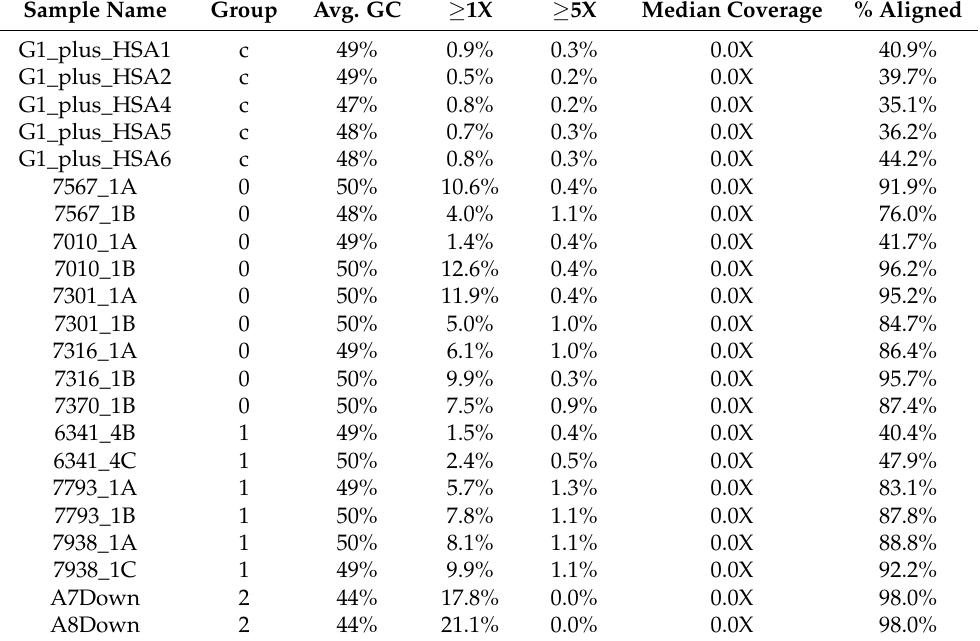
Table 1. Mapping quality metrics of the selected control media samples (c.), culture media droplets from embryos of miscarriage (0), culture media droplets of healthy neonates (1), cord blood sample with known CNVs